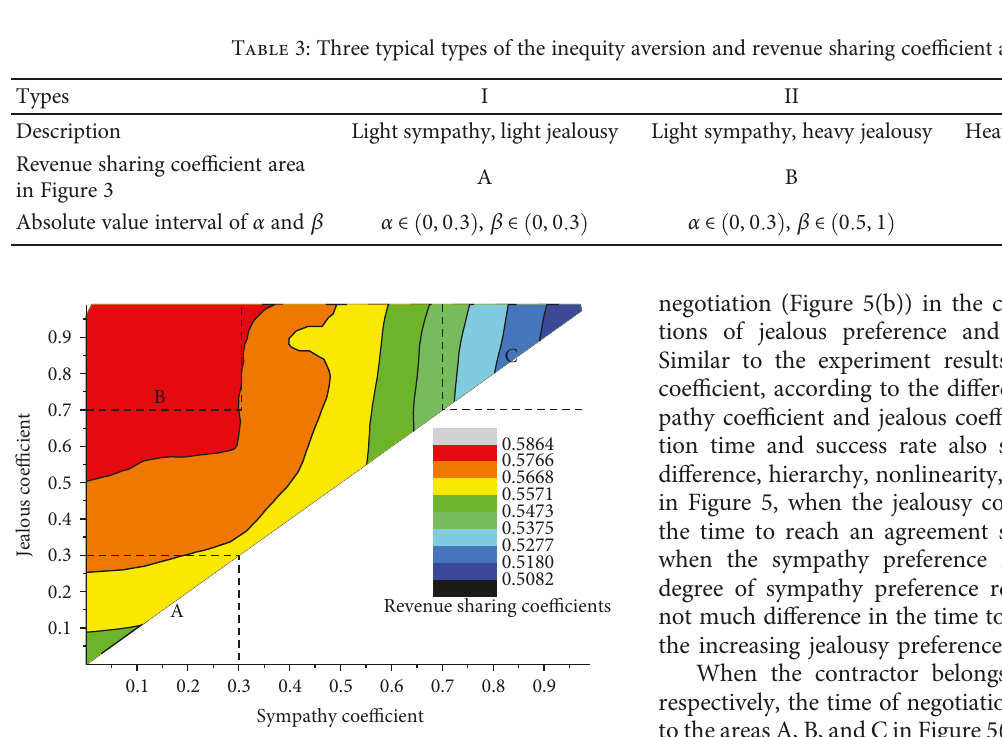
Figure 3: Revenue sharing coe ffi cients under di ff erent combinations of sympathy and jealousy preference.